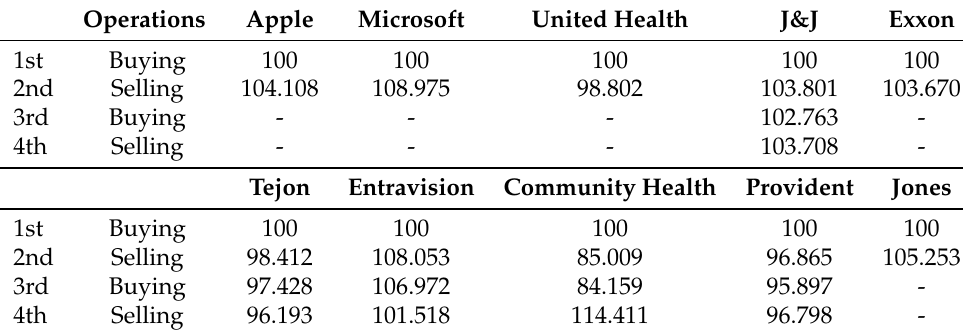
Table 8. Net performances for a TI-SiSS trading strategy for the most/least capitalized companies. To determine the net performance, we consider 1% of wealth as a multiplicative transaction cost for each buying/selling